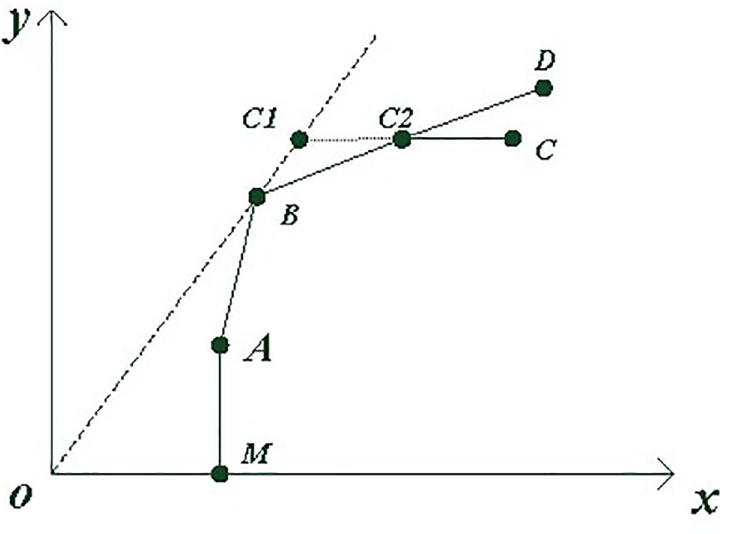
Fig 1. Diagram of the basic principle of the investment-oriented